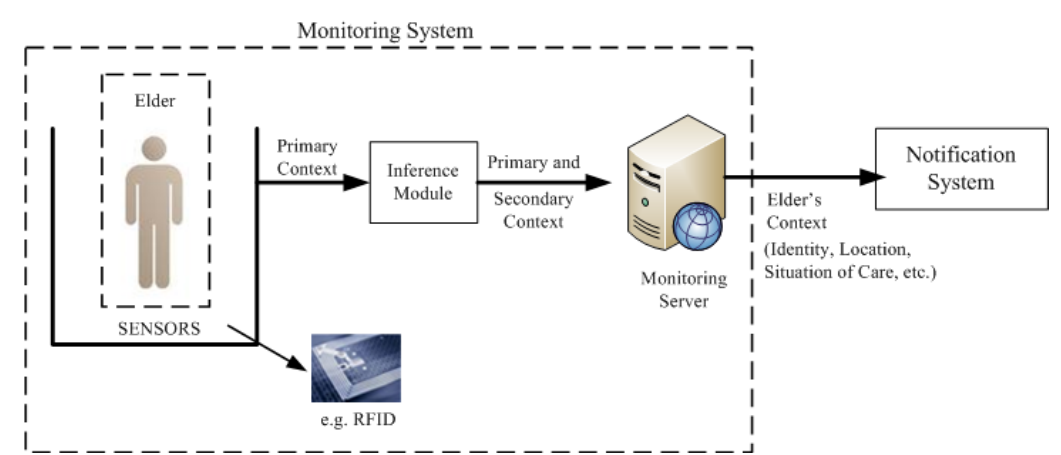
Figure 5. Architecture of the proposed Monitoring System.